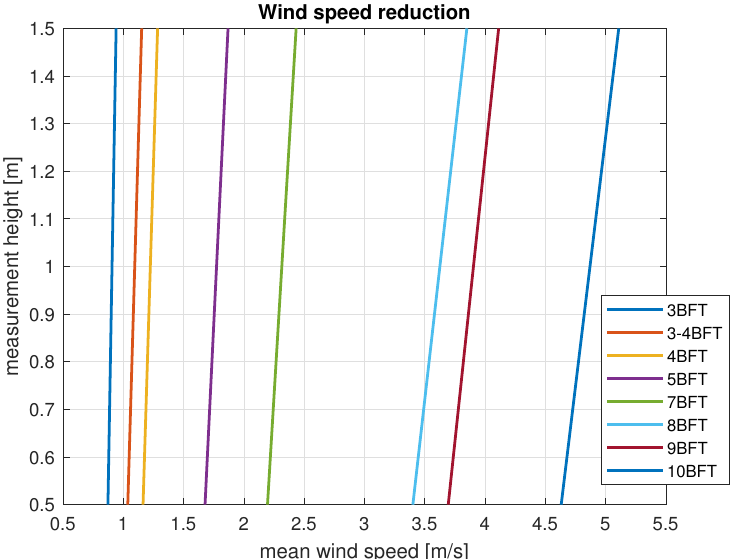
Figure 7. Wind speed reduction for all registered wind forces in BFT in ship scale. Analysis of this data shows that wind speed for all registered categories decreases with the measurement height reduction. In order to prove measurements quality and to validate data, compliance of the obtained results with the wind profile power law was checked. Analysis was performed based on the high anemometer mean wind speed for 120 s periods. According to the Equation (7) mean wind speed at the 0.5 m above the water level was estimated. Results were compared with mean wind speed registered by the low anemometer and collected in Table 2.